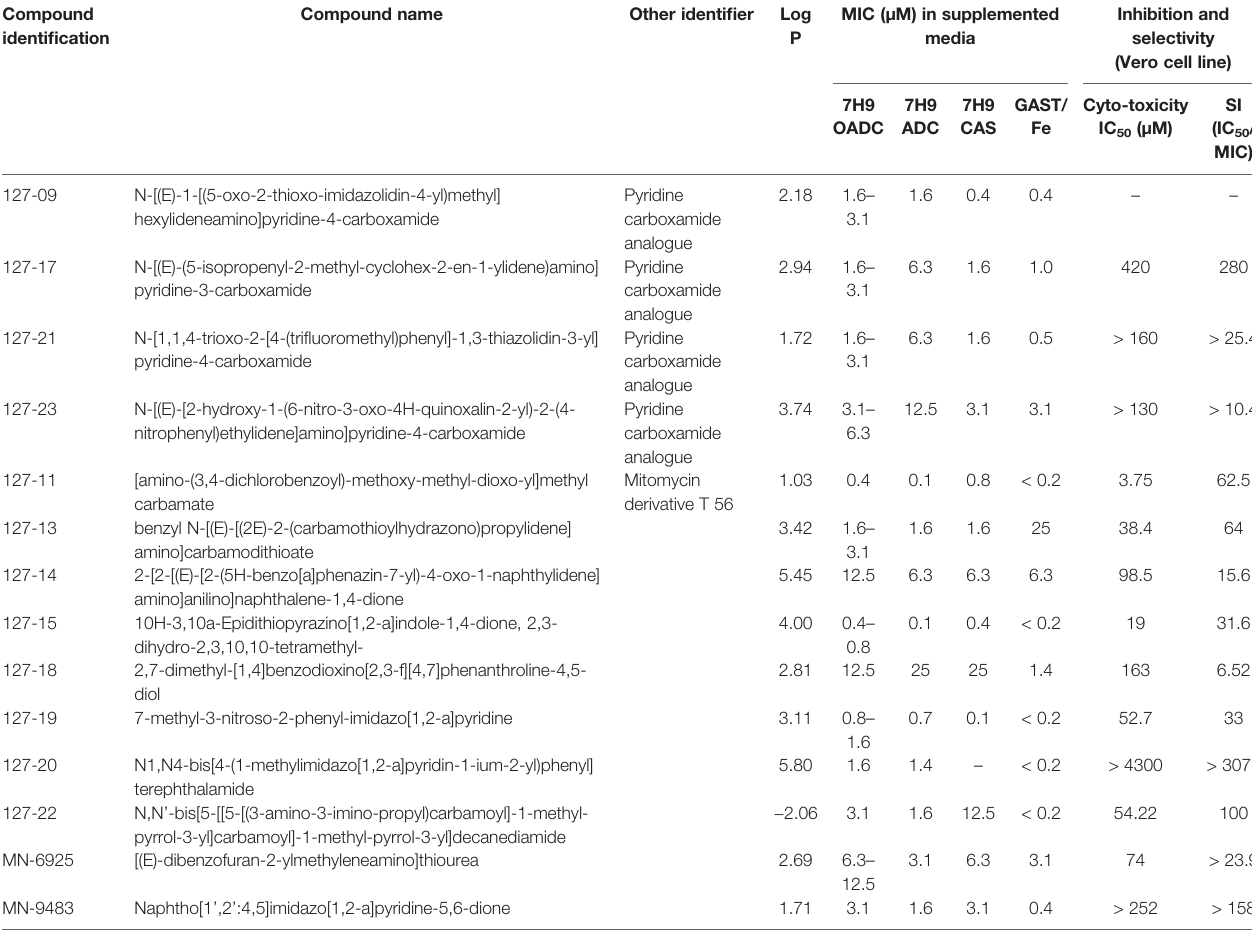
TABLE 1 | Inhibitory activity against replicating Mtb and mammalian cell toxicity of